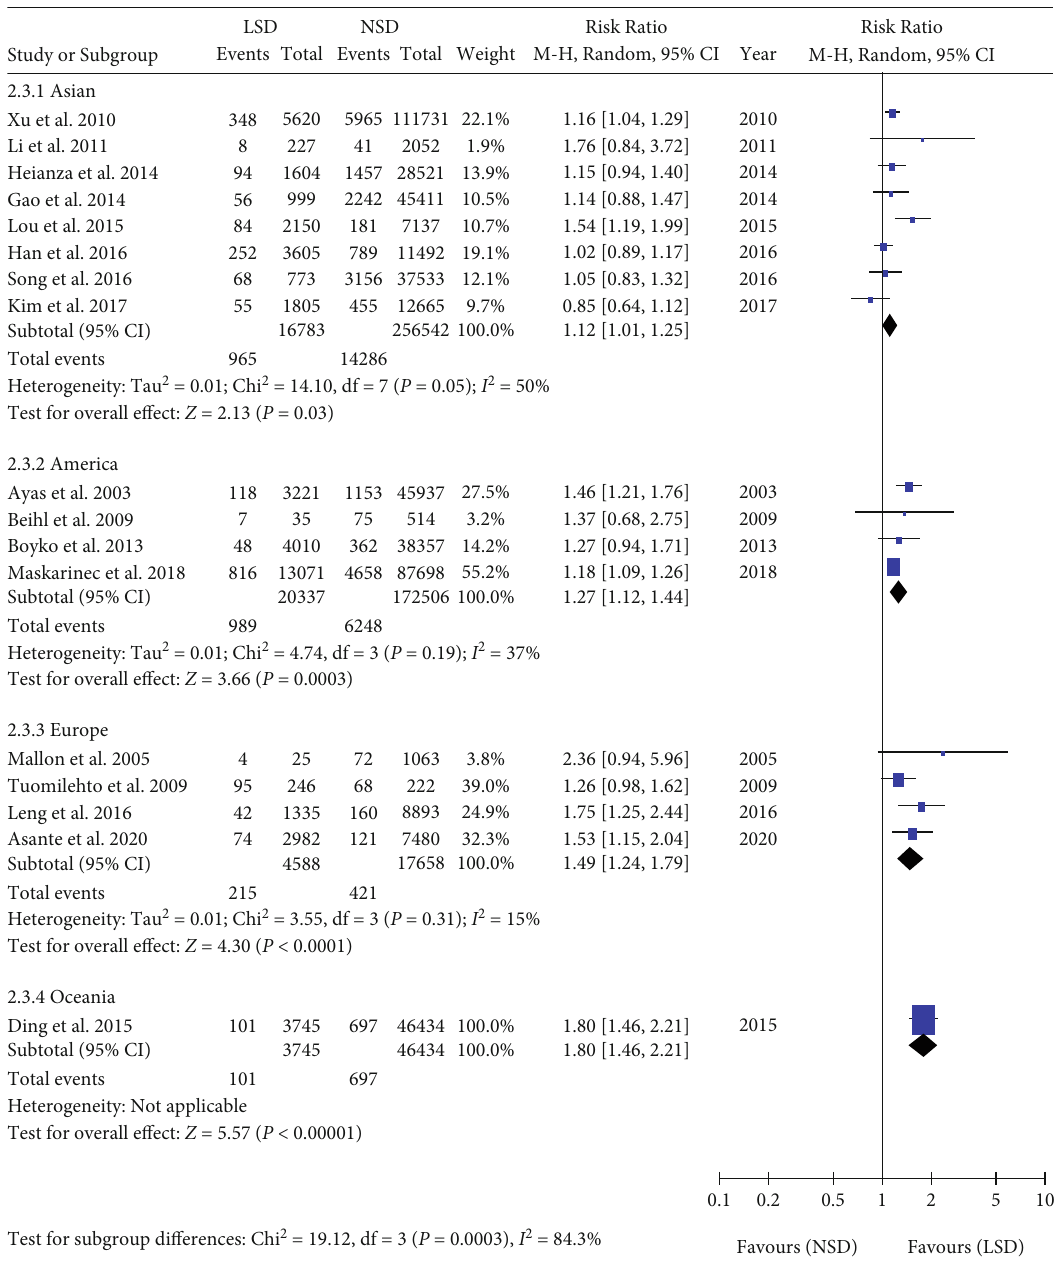
Figure 7: Regional subgroup analysis of the association between LSD and